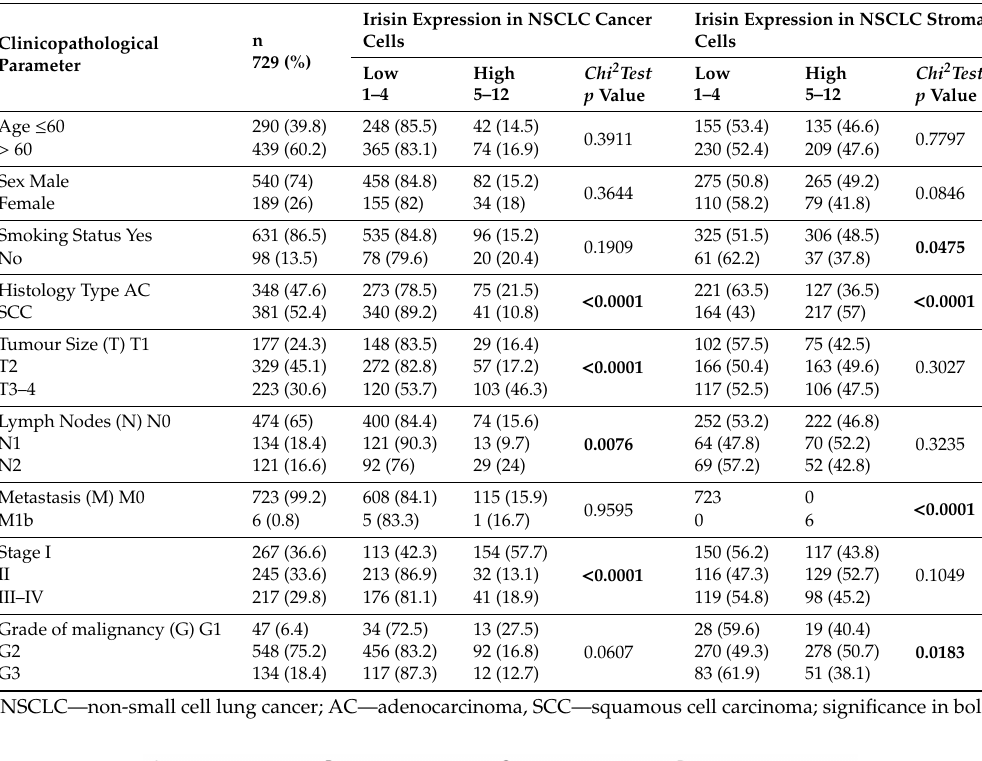
Table 1. Clinicopathological characteristics of NSCLC patients related to irisin expression in cancer cells and stoma cells.